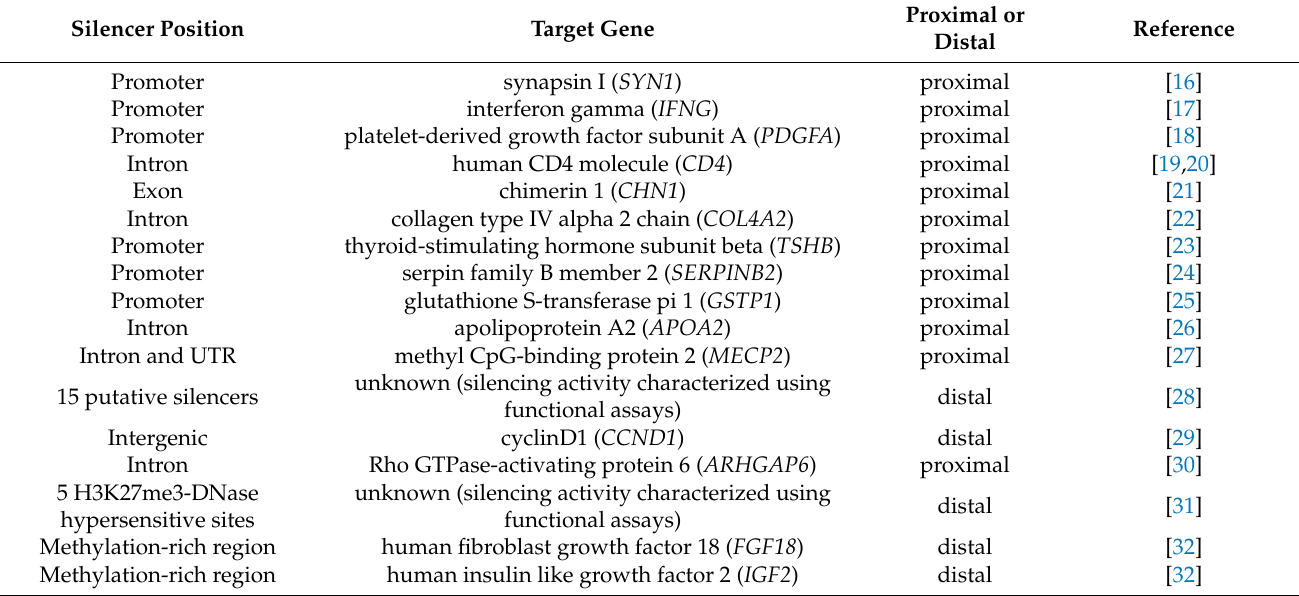
Table 1. Validated examples of human